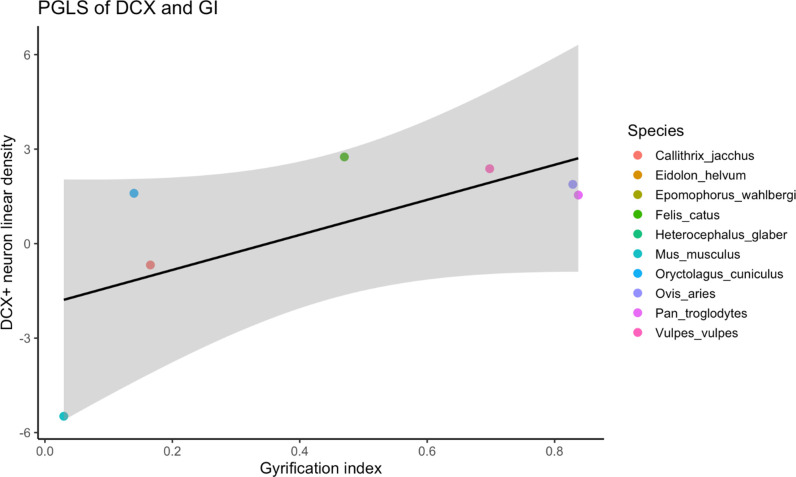
PGLS regression analysis between layer II DCX+ neuron density and gyrification index.The relationship between these two variables approached significance, but no phylogenetic signal was found (adjusted r2 = 0.328, p=0.10, Pagel’s lambda = 0.00), indicating that the two traits evolve independently from phylogenetic covariance.